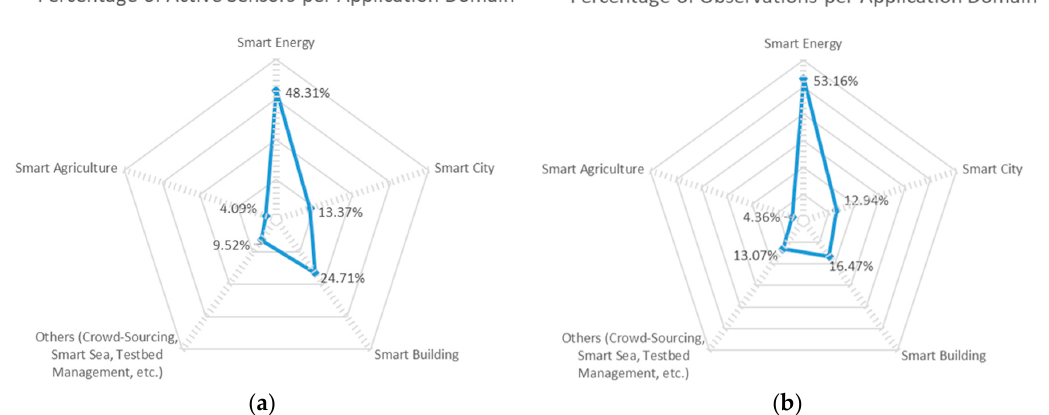
Figure 6. Distribution of active sensors ( a ) and observations ( b ) per application domain.